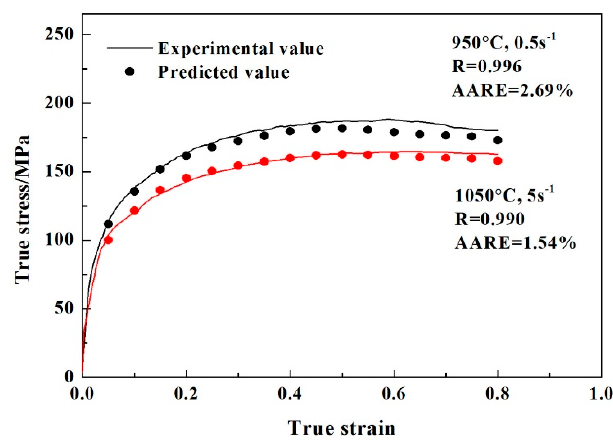
Figure 8. ( a ) Comparison between the values of the experimental and predicted true stress when strain rate is 1 s − 1 ; ( b ) Correlation between experimental and predicted true stress in this study.